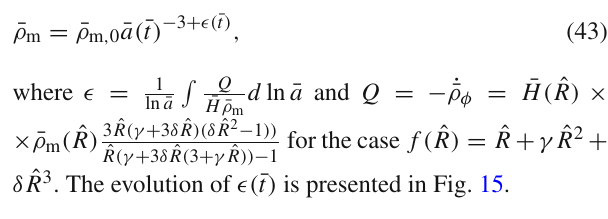
parametrization of dark energy is uniquely determined. In general it is obtained in the covariant form as a function of the Ricci